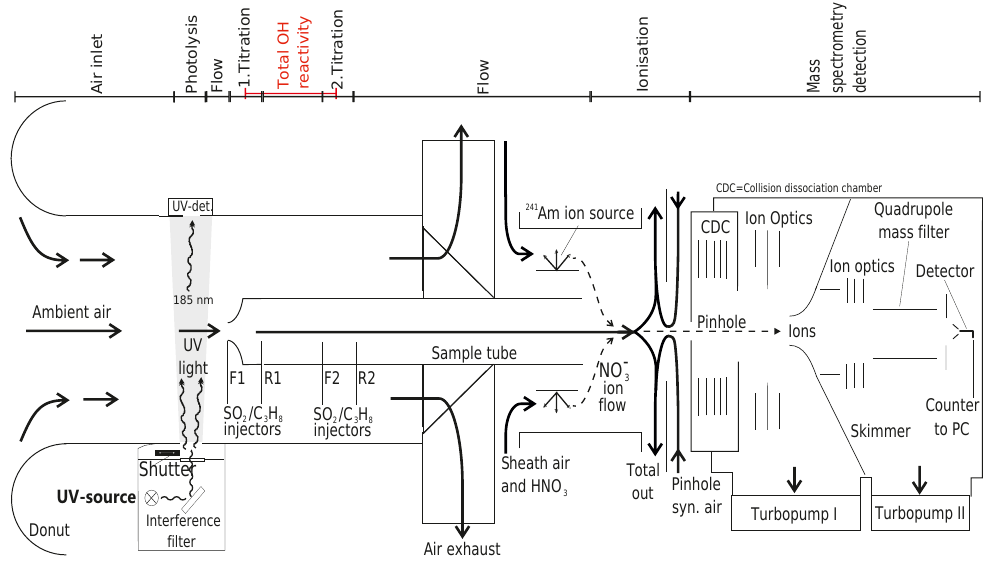
Figure 1. Schematic of CIMS system used for long-term OH, H 2 SO 4 and OH reactivity measurements at the Meteorological Observatory Hohenpeissenberg, Germany. Air flows are indicated by arrows, the measurement zones are described in the upper part of the